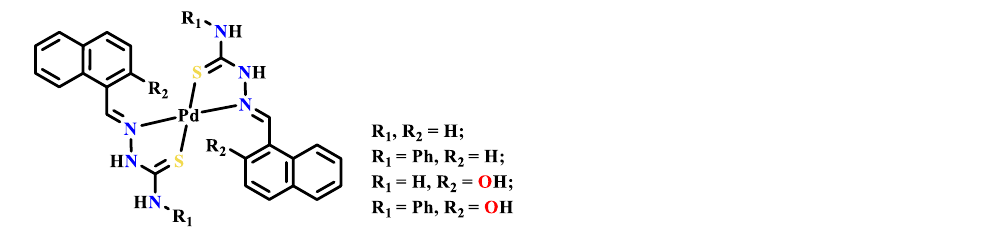
Figure 31. A series of Pt(II) complexes of naphthylhydrazone with different benzamide derivatives as side chains. Early in 2 010, Višnja Vrdoljak et al. [ 107] reported a series of +6 molybdenum(VI) complexes containing different substituent groups with aromatic hydrazones as ligands, including two Mo(VI) complexes with 2-hydroxylnaphthylhydrazone (Figure 32). This is also the first report detailing the biological activity of naphthylhydrazone-Mo(VI) com- plexes, in which the side chains of naphthylhydrazone were chosen to be thiourea and phenylthiourea, respectively. Among all of these complexes, the hydrazone ligands all coordinated with Mo(VI) in O / N / S -tridentate mode. The Mo(VI) complexes of two naph- thylhydrazone showed significant differences in their anticancer activity. The Mo(VI)